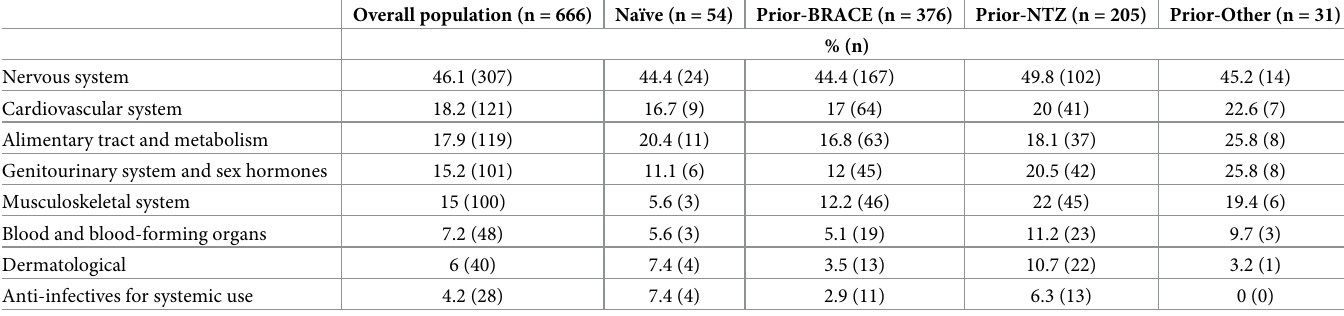
Table 2. Patients with concomitant medication after fingolimod